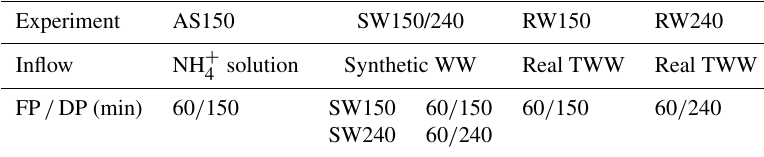
Table 1. Inflow composition and flooding/drying periods in the four discussed experiments.